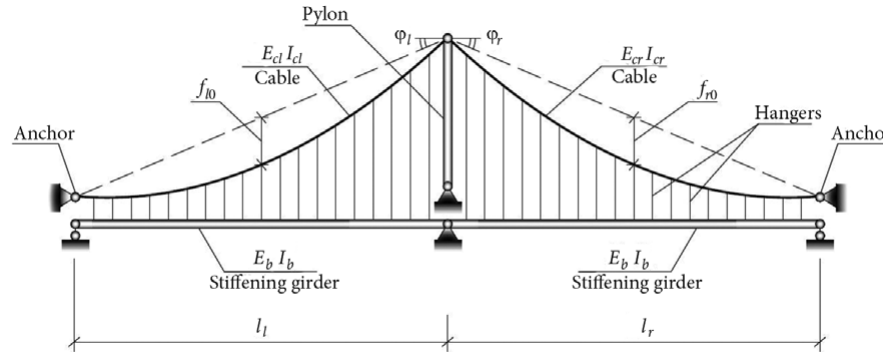
Fig. 1. The structure of suspension